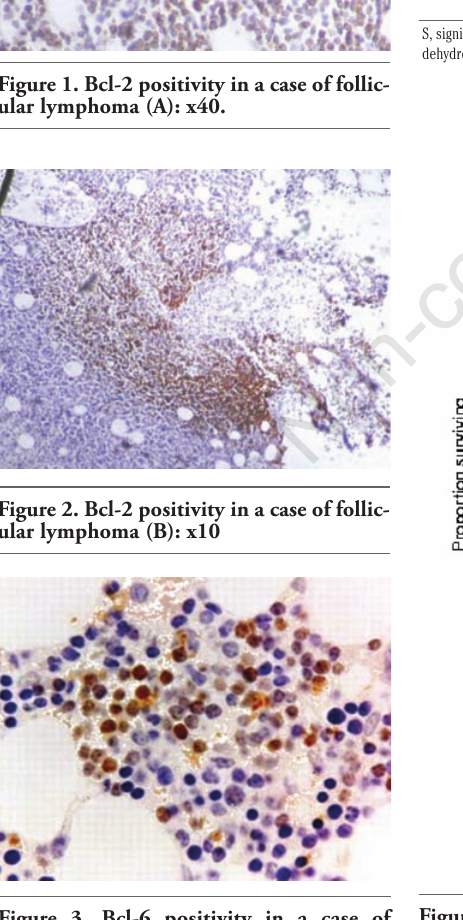
Figure 3. Bcl-6 positivity in a case of DLBCL (x40).